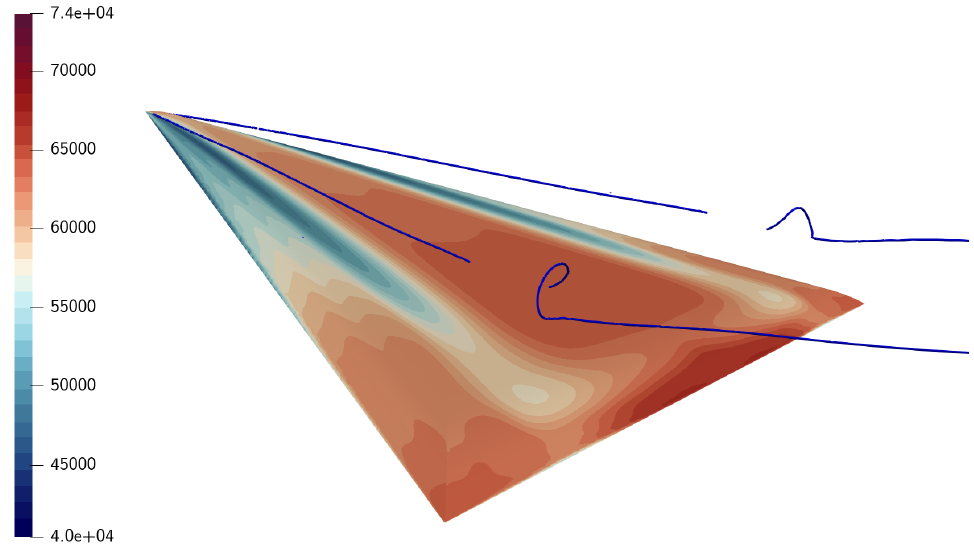
Figure 16. Vortex core lines associated with the main leading edge vortices, extracted through the vortex core tool of Paraview 5.9.0. Surface contours represent surface pressure.